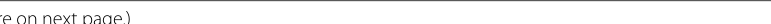
figure on next Fig. 3 Potamopyrgus antipodarum. Mean and standard error of percentage mortality ( a , c , e ) and mean and standard deviation of embryo numbers ( b , d , f ) in active biomonitoring campaigns at the rivers Nidda, Usa and Horloff (Field) and in laboratory experiments with combined water/sediment samples (Lab) of the corresponding sampling sites. Significant differences in mortality compared to the corresponding reference site N1, U1 or H1 (shaded) were determined using Fisher’s exact test. Significant differences in embryo numbers in the field in comparison with the corresponding reference site were determined via unpaired t test. Significant differences in reproductive output in the lab compared to the corresponding reference site were determined using Mann–Whitney test. * p < 0.05, ** p < 0.01, *** p < 0.001, n Field